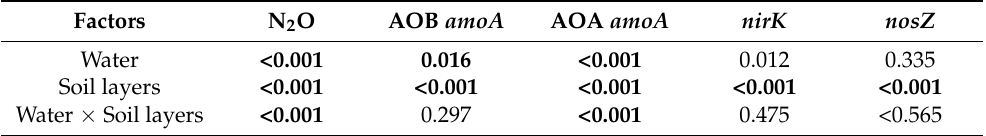
Table 2. Summary for the two-way ANOVA on N 2 O emission and AOB, AOA, and nirK and nosZ gene abundance for the two factors (soil moisture and soil depth) in the two paddy